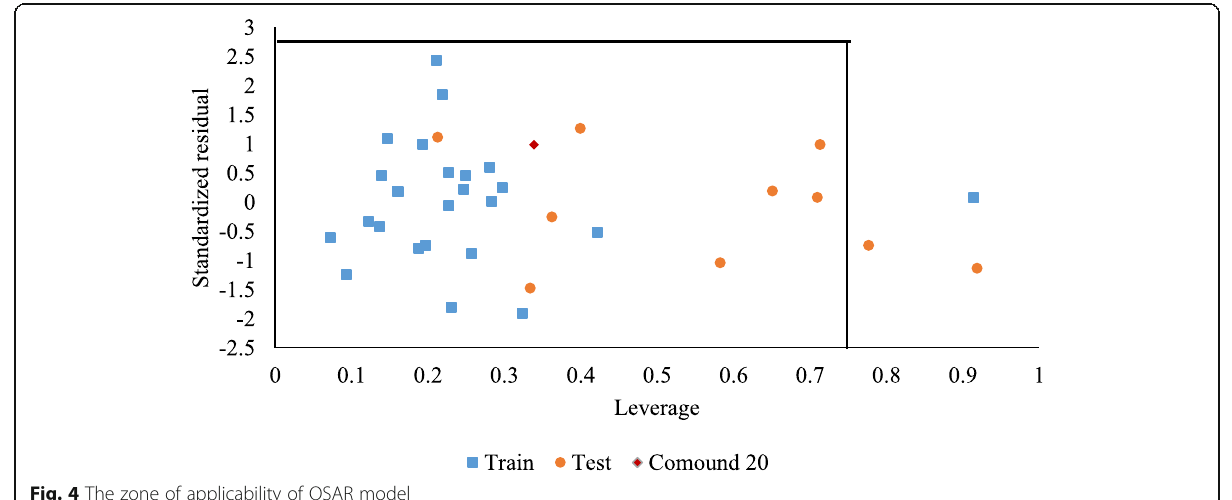
Fig. 4 The zone of applicability of QSAR model